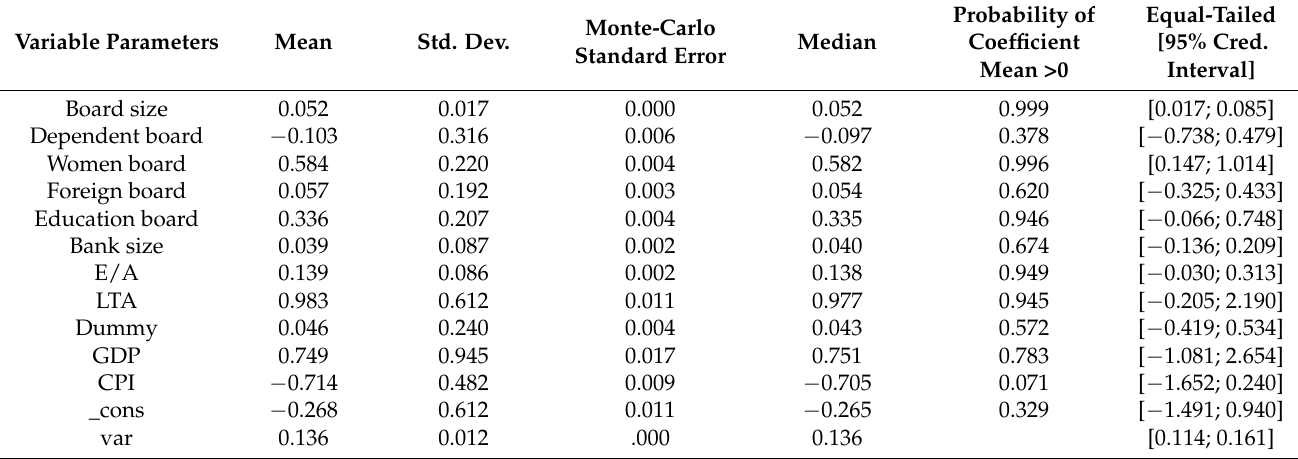
Table 5. The simulation results of Bayesian Mixed-Effects